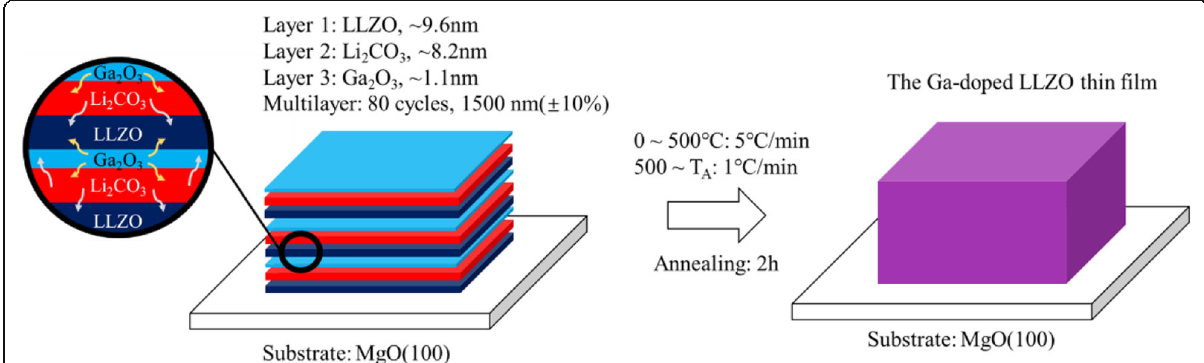
Fig. 2 Schematics of fabrication procedures of the presented LLZO thin